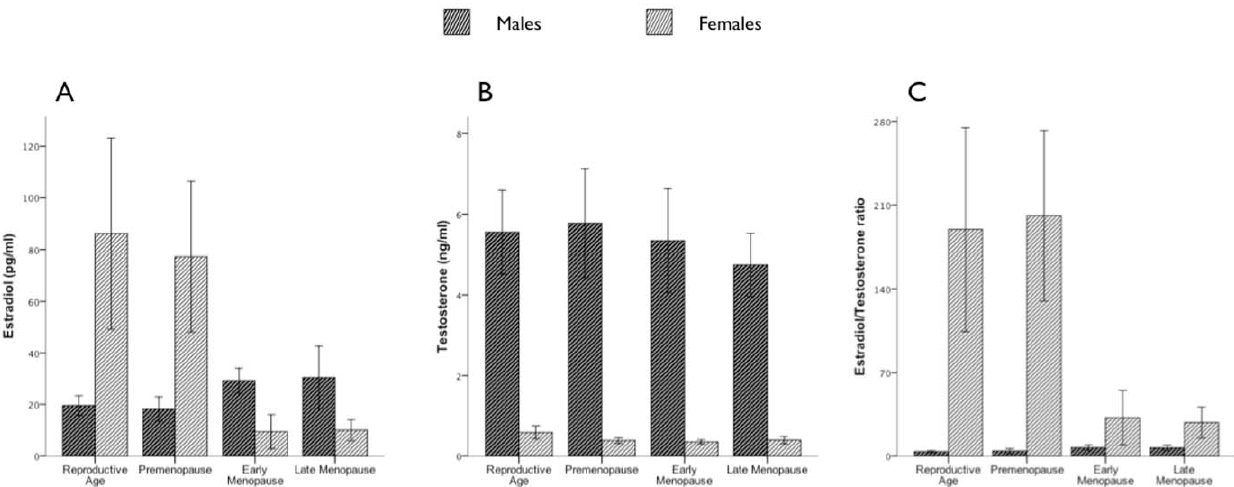
Figure 3. Estradiol and Testosterone serum levels and E2/T ratio in men and women divided according to women’s reproductive phases as described in Methods. Values (reported as mean 6 SD) were compared by Mann-Whitney test. The levels of significance are reported in the text.